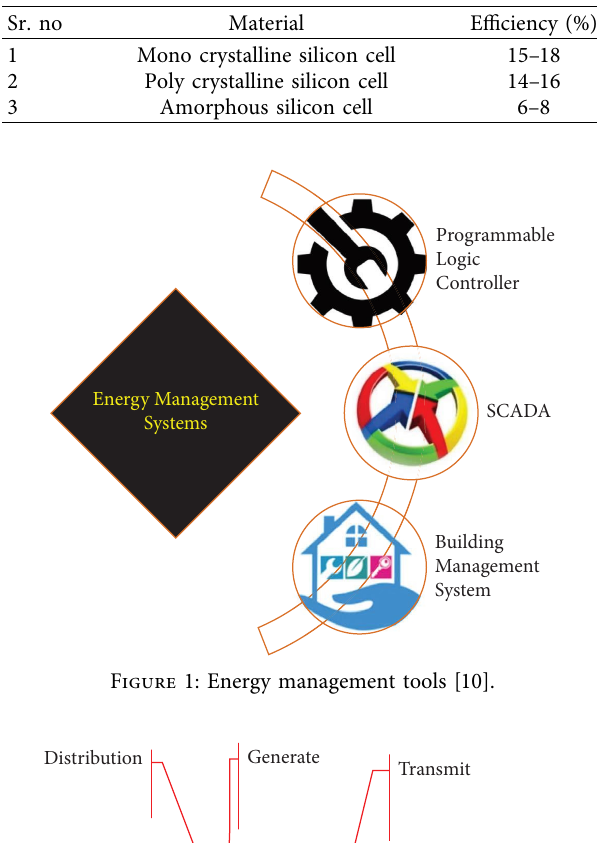
Table 1: Solar cell efciency.